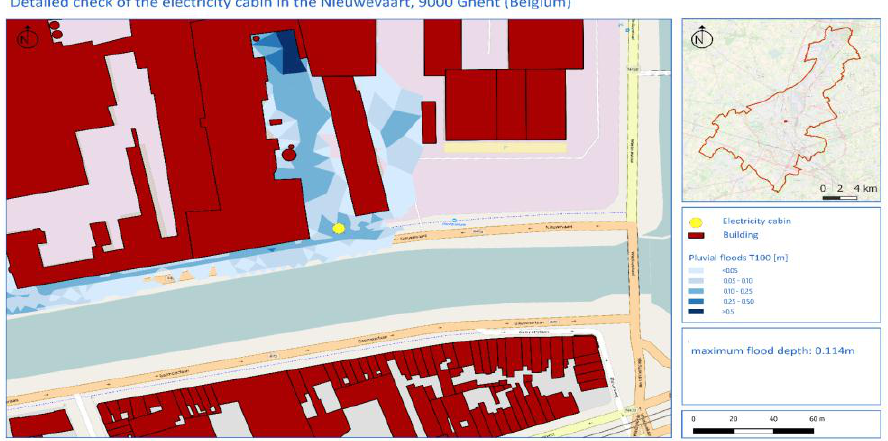
Figure 14. Example of a detailed check map of an electricity cabin for the city of Ghent by FLIAT tool, for a pluvial flood with a return period of 100 years.